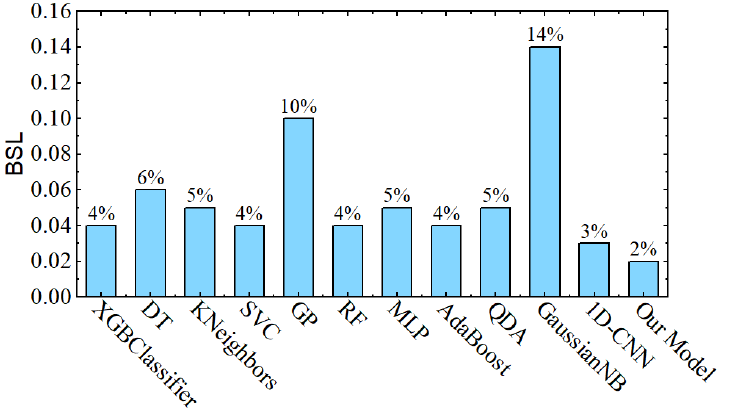
Figure 13. Final Brier Score Loss results of the proposed model in comparison with other paradigms.